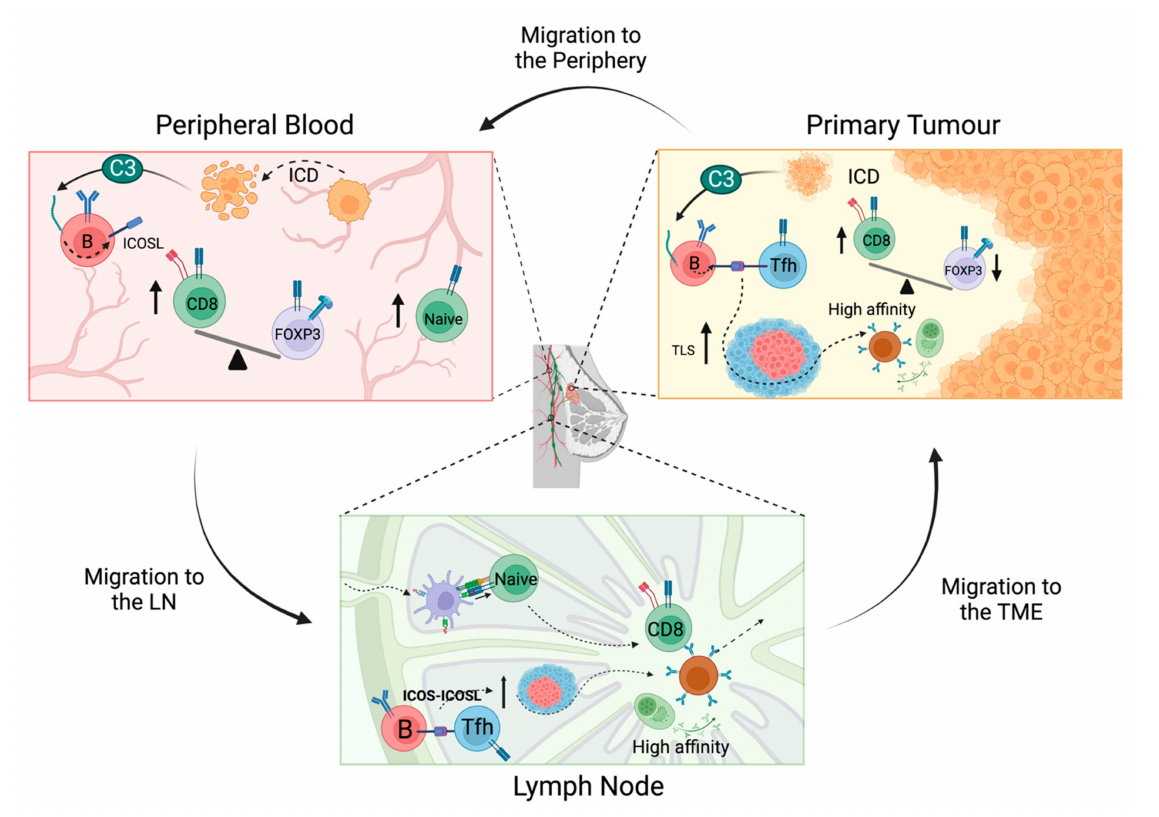
Figure 3. Immunostimulatory effects of chemotherapy across the immune macroenvironment.